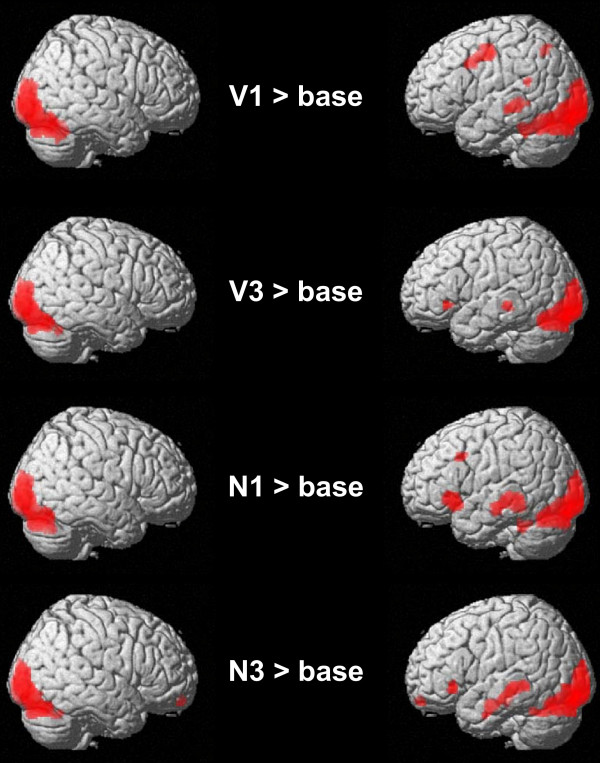
Shows the general activity pattern elicited by the four experimental conditions compared to the fixation baseline (N1/3 refers to one-/three-place verbs preceded by a name; V1/3 refers to one-/three-place verbs preceded by a senseless letter string). Only clusters surviving a threshold of p < .05 family wise error-corrected (FWE) and a cluster extent of k>20 are reported; the voxel threshold was set to p < .001 (uncorrected). Right column = left side of the brain.